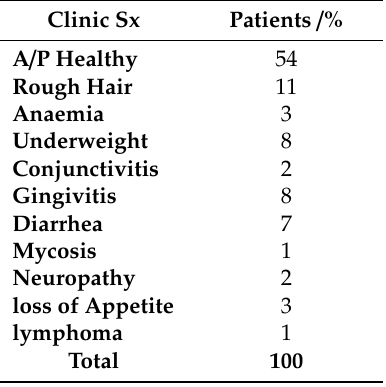
Table 2. Main clinical signs (Sx) of patients included in the study, with the total of felines that presented the same